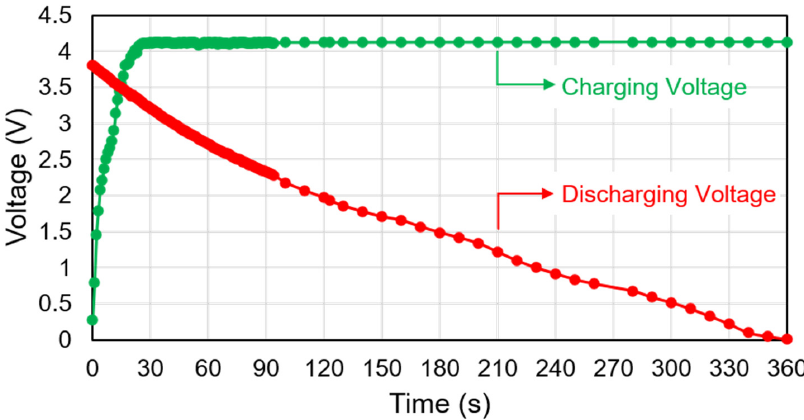
Figure 8. Charging and discharging state of the